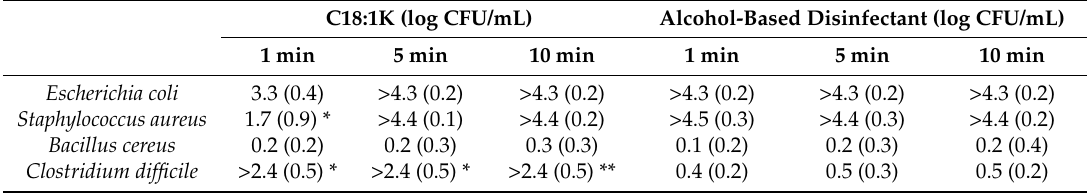
Table 1. Bactericidal activity of C18:1K and an alcohol-based disinfectant.